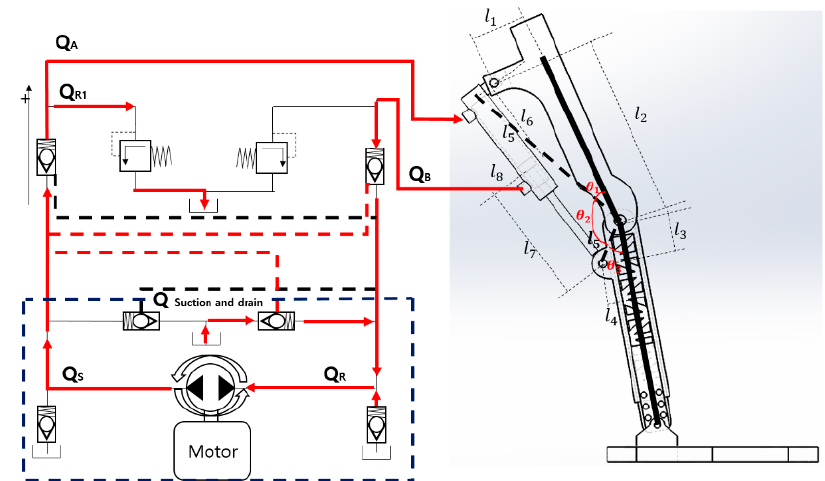
Figure 1. Block diagram of the locking circuit in the pump-controlled EHA system. The locking valves in the locking circuit are located in both hydraulic fluid passages and serve to maintain the pressure in the actuator.